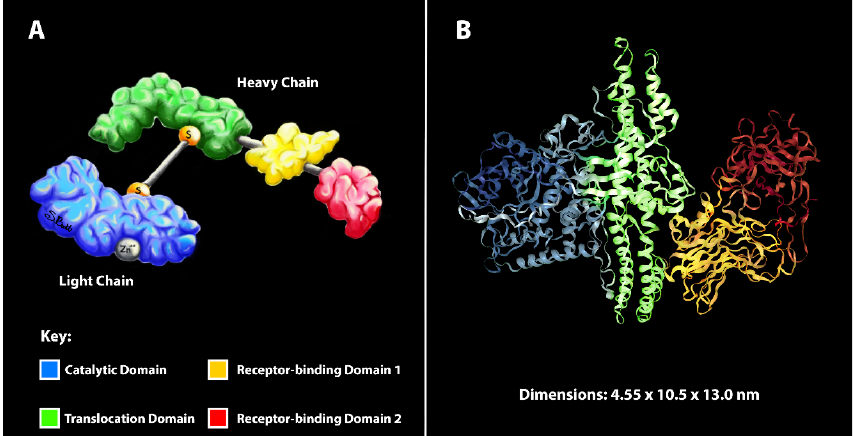
Figure 1. Structure-function relationships of botulinum neurotoxins (BoNTs). ( A ) Cartoon summarizing the various domains of BoNT holotoxin. Functional domains are distinguished by colors according to the key. The catalytic zinc is grey and the disulfide bond is formed between two cysteines (orange). ( B ) Ribbon structure of BoNT/A, including unit dimensions of the crystallized toxin from [4]. Colors correspond to panel ( A ).